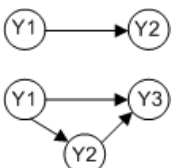
Figure 3. Structures for a synthetic experiment. All nodes are